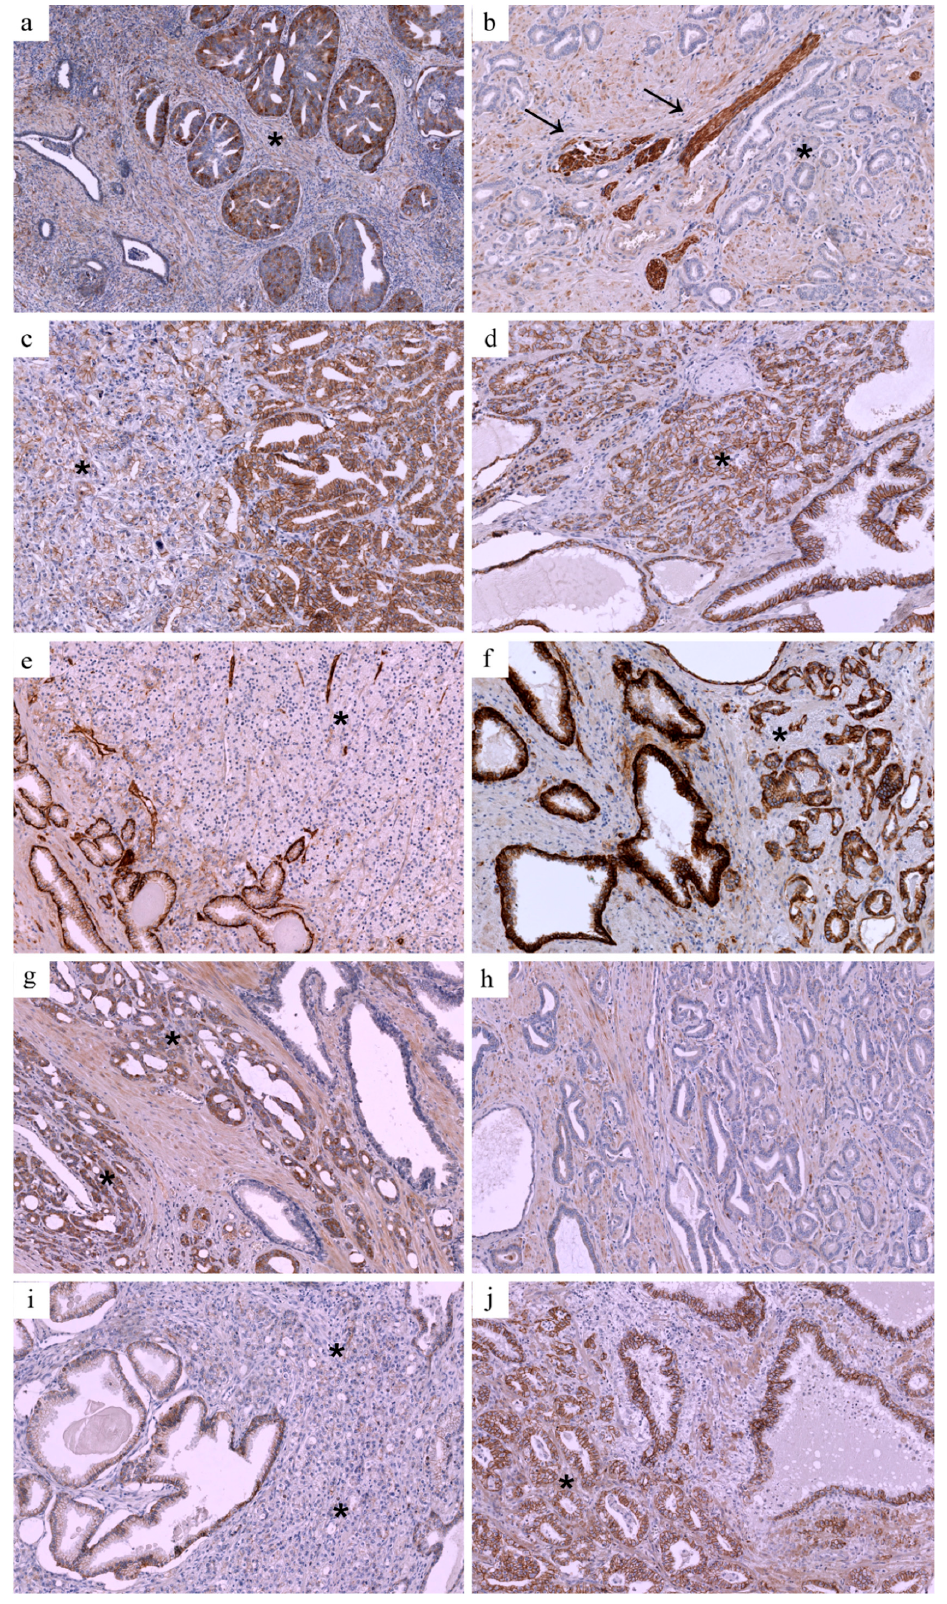
Figure 1. Examples of TFR, e-cadherin, and CD49 immunoreactivity in PCa. ( a ) High-grade PCa with positive TFR expression (marked with asterix); benign prostate glands are visible on the left and serve as internal negative control. ( b ) Low-grade PCa with negative TFR expression; TFR-positive nerve bundles are visible in the center and serve as